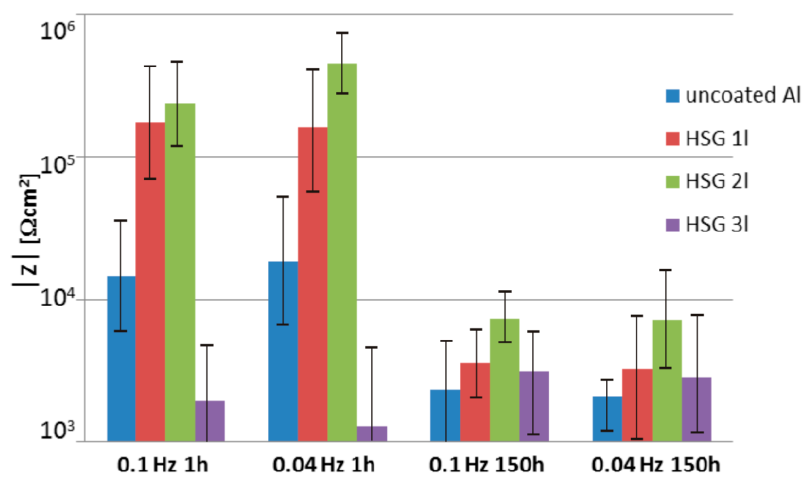
Figure 6. Comparison of the impedance modulus of HSG coatings and an uncoated aluminum alloy at 0.04 Hz and 0.1 Hz.